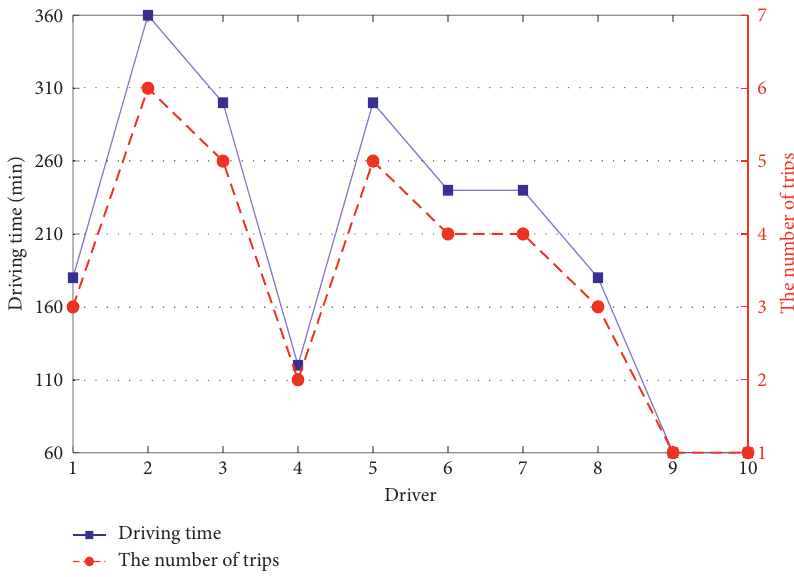
Figure 5: Driving time and the number of trips assigned to each